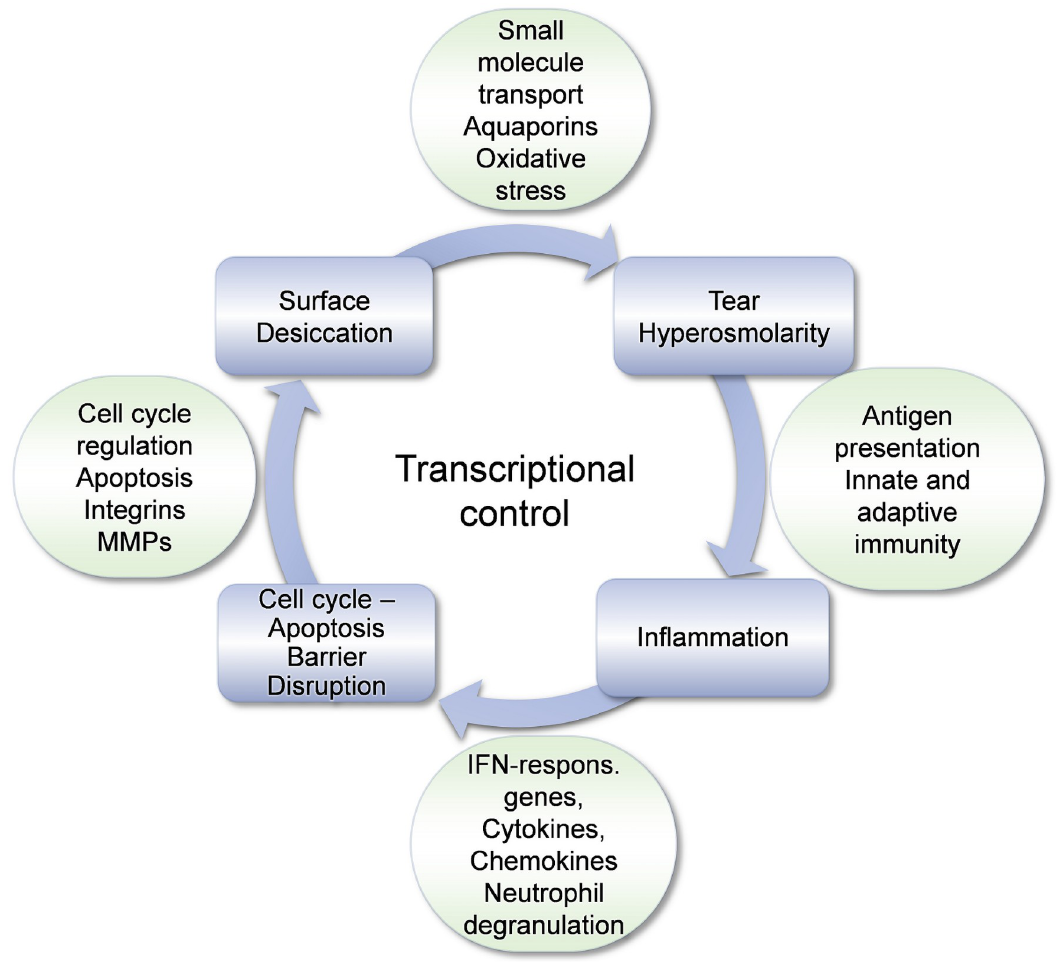
Fig 9. Transcriptome changes during the vicious cycle of DED. The four components of the vicious cycle of the pathophysiology of DED are shown. Representative changes in gene expression observed in rabbits with DED are linked to each stage of the cycle. Changes in genes involved in transcriptional control (depicted at the center of the cycle) likely affect all stages of DED evolution.